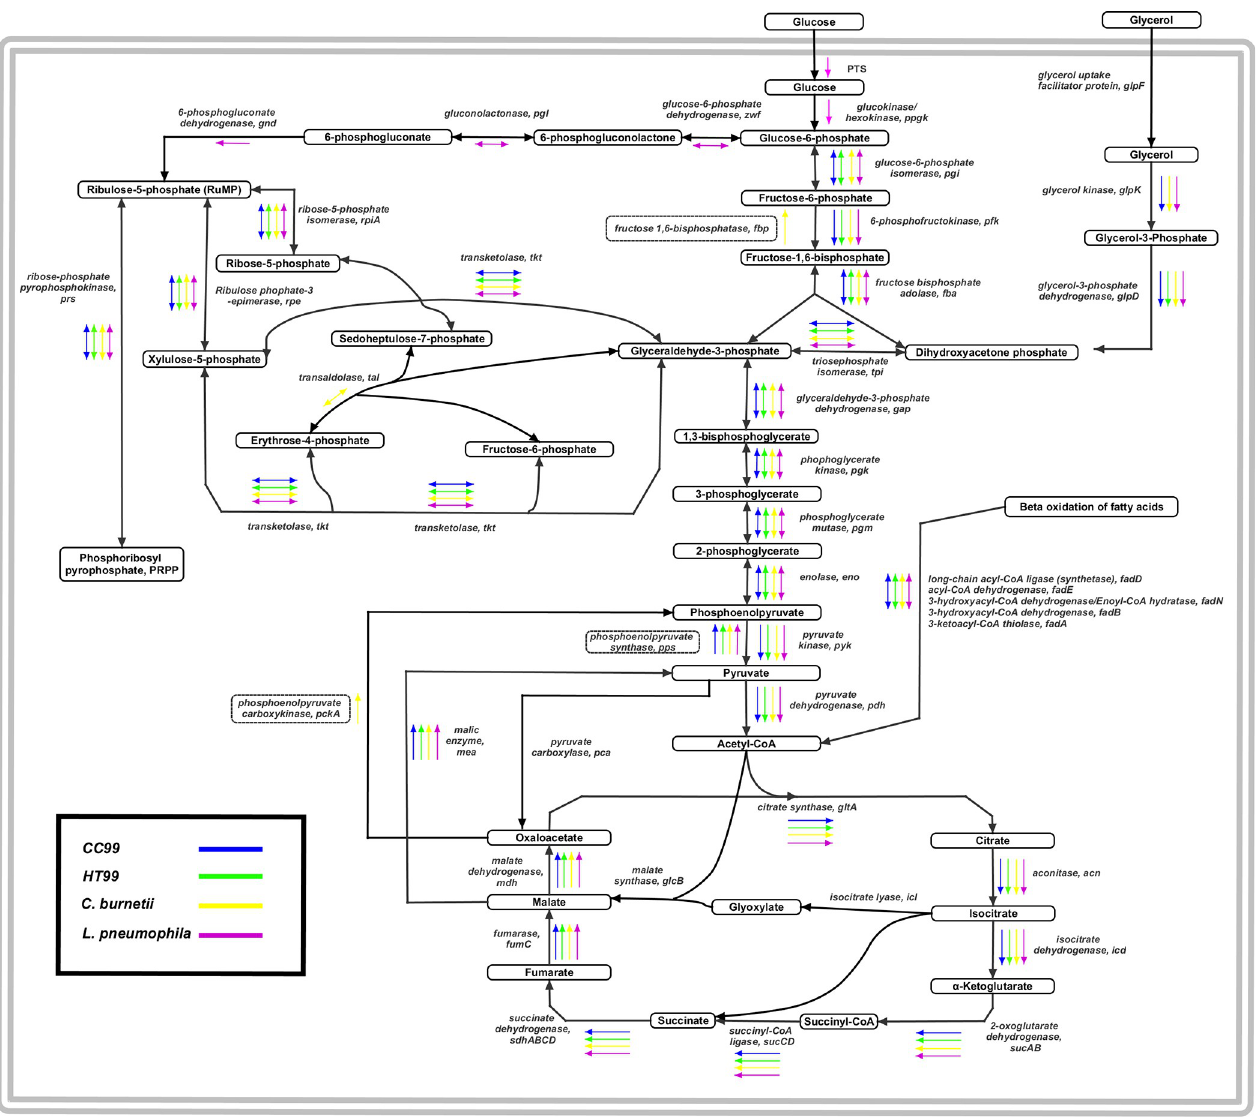
Fig 3. Genome inferred central carbohydrate metabolic pathway of “ Ca . B. cookevillensis” (CC99) and “ Ca . B. aquae” (HT99) with comparisons to C . burnetii and L . pneumophila . Genes encoding enzymes involved in the EMP of glycolysis (except for glucokinase) and non-oxidative branch of the PPP were identified in both CC99 and HT99 (indicated by blue and green arrows, respectively). Genes for enzymes involved in the oxidative branch of PPP pathway and the ED pathway were absent. Genes encoding enzymes involved in the TCA cycle were present in both bacteria. Genes encoding enzymes for these pathways in C . burnetii (yellow arrows) and L . pneumophila (pink arrows) are included for comparison.